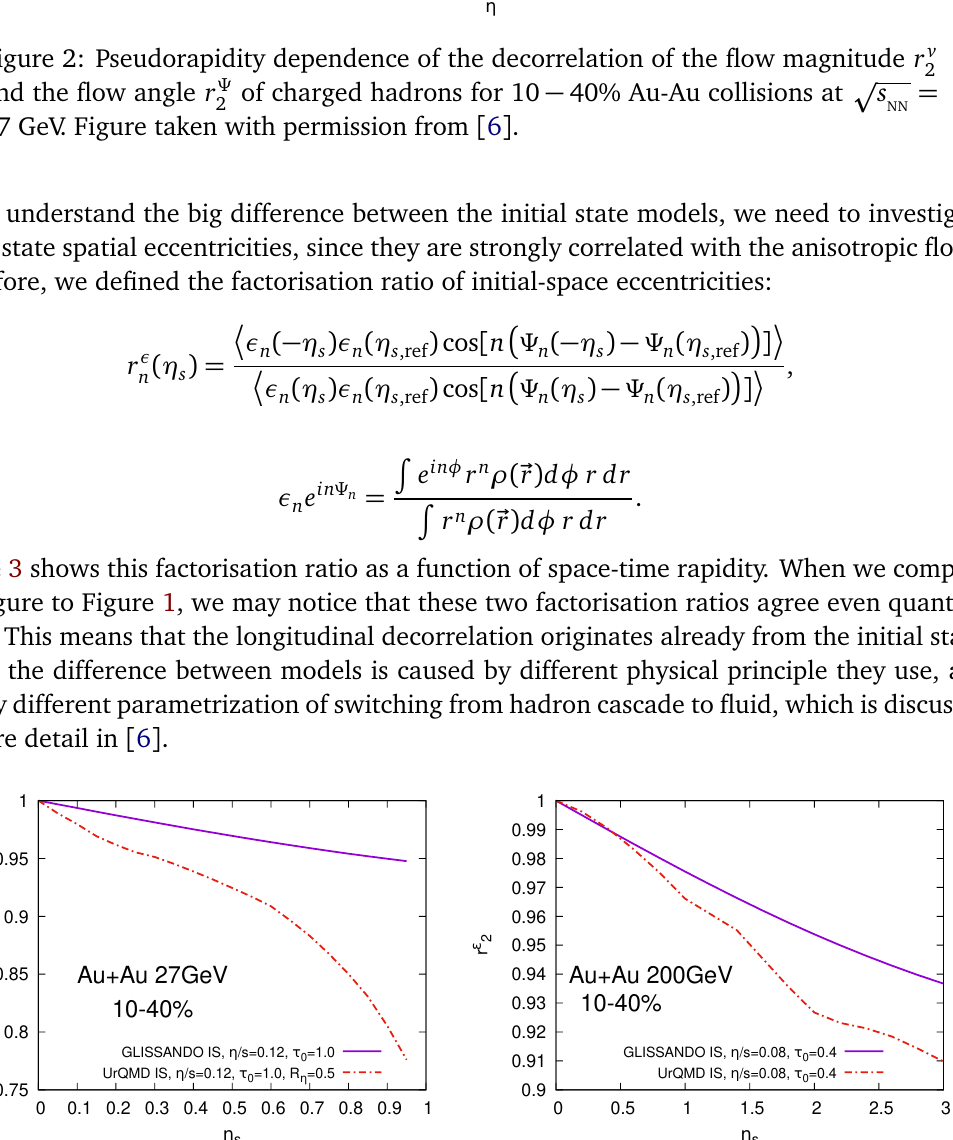
= 27 and 200 GeV. Figure taken with NN